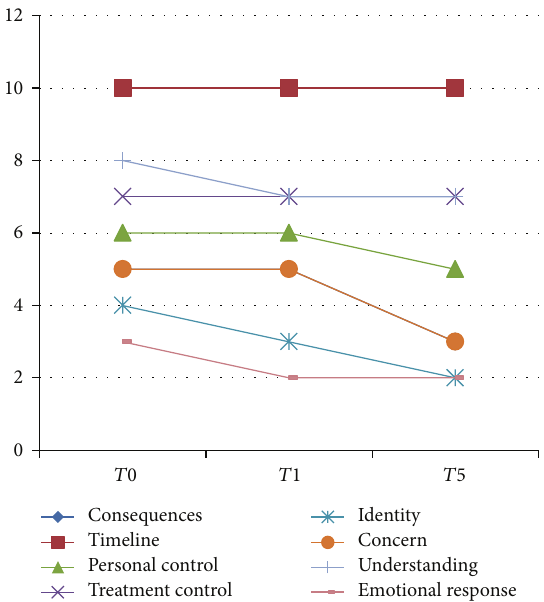
Figure 3: Graphical representation of longitudinal data on IPQ items. The timeline of the 3 assessments is presented in the 𝑋 - axis. The median values for each item are presented in the 𝑌 -axis. Different colours are indicating the items. Item 1 (consequences) coincides with item 6 (concern). A reduction of 2 points is observed fortheitems1and5(consequencesandidentity),assessingcognitive illness representations. The item “illness identity” is a measure of the signsandsymptomsperceivedbythepersontobepartofthedisease. The item “illness consequences” refers to the perceived effects and outcomes of illness. The median values of this item coincide with those of item 6 (concern). The item “concern” (item 6) assesses emotional